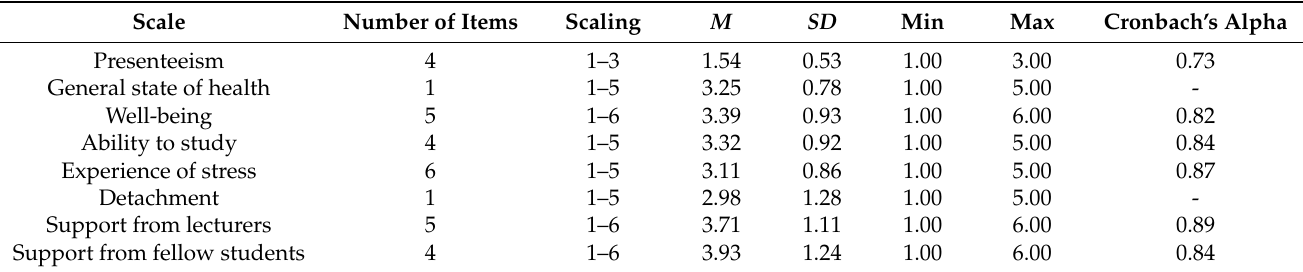
Table 3. Descriptive statistics and reliability of the scales.